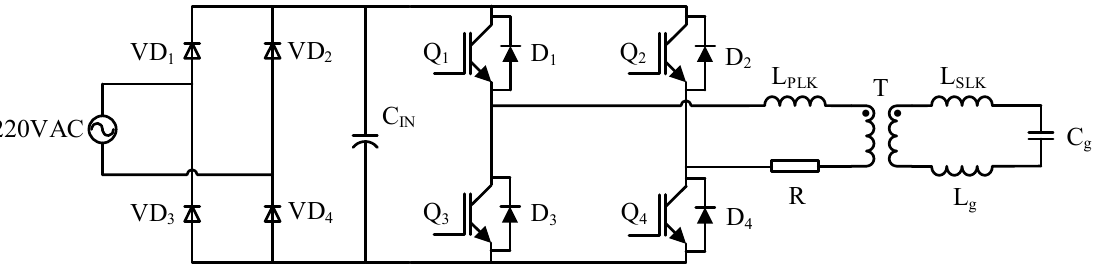
Figure 2. Cross section of plasma torch: ( a ) Lateral section; ( b ) Frontal section; ( c ) Real figure. Plasma torch load is imposed by the working gas, nitrogen, argon, or compressed air.